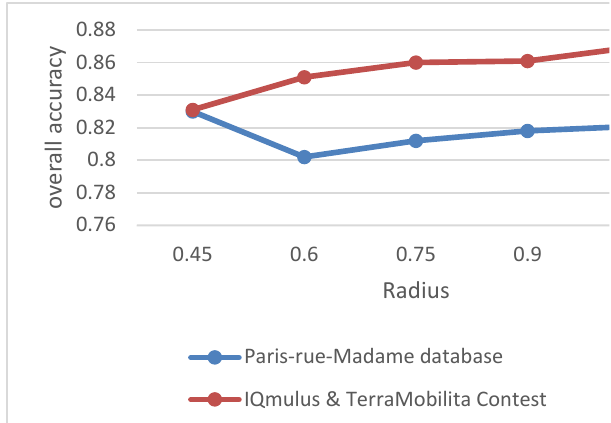
Figure 2. Overall accuracy using a range radius size for two point cloud bench mark datasets.